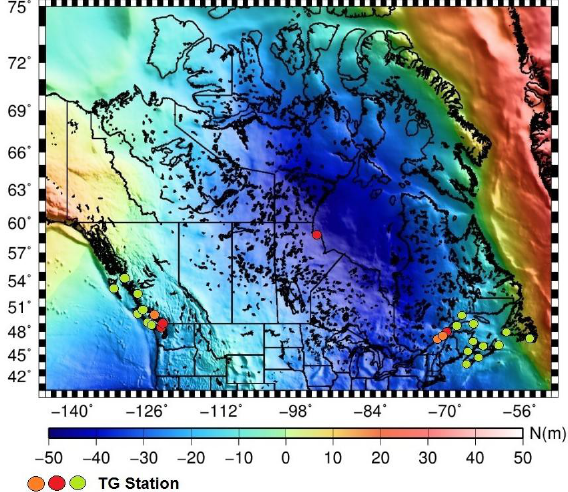
Figure 2. 27 permanent TG stations and CGG2010 geoid